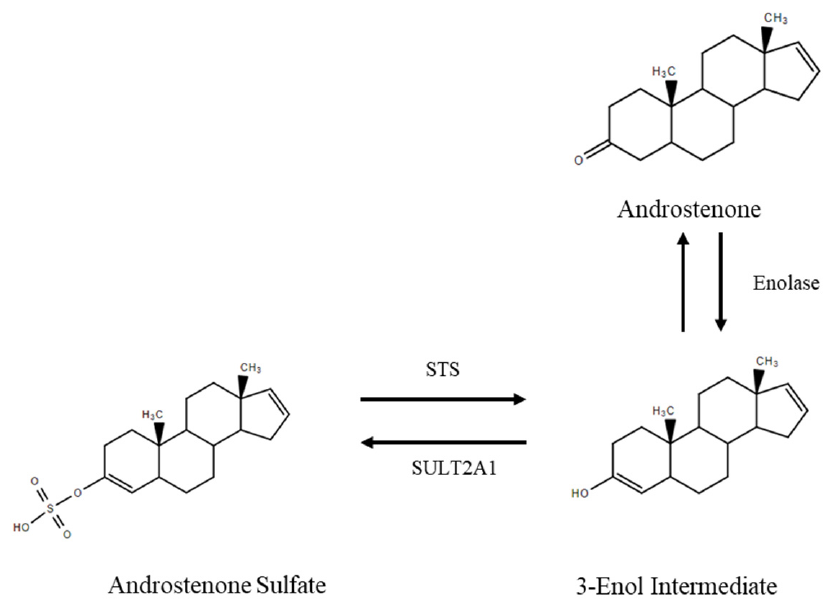
Figure 6. Proposed mechanism for the sulfoconjugation of androstenone and deconjugation of androstenone sulfate.